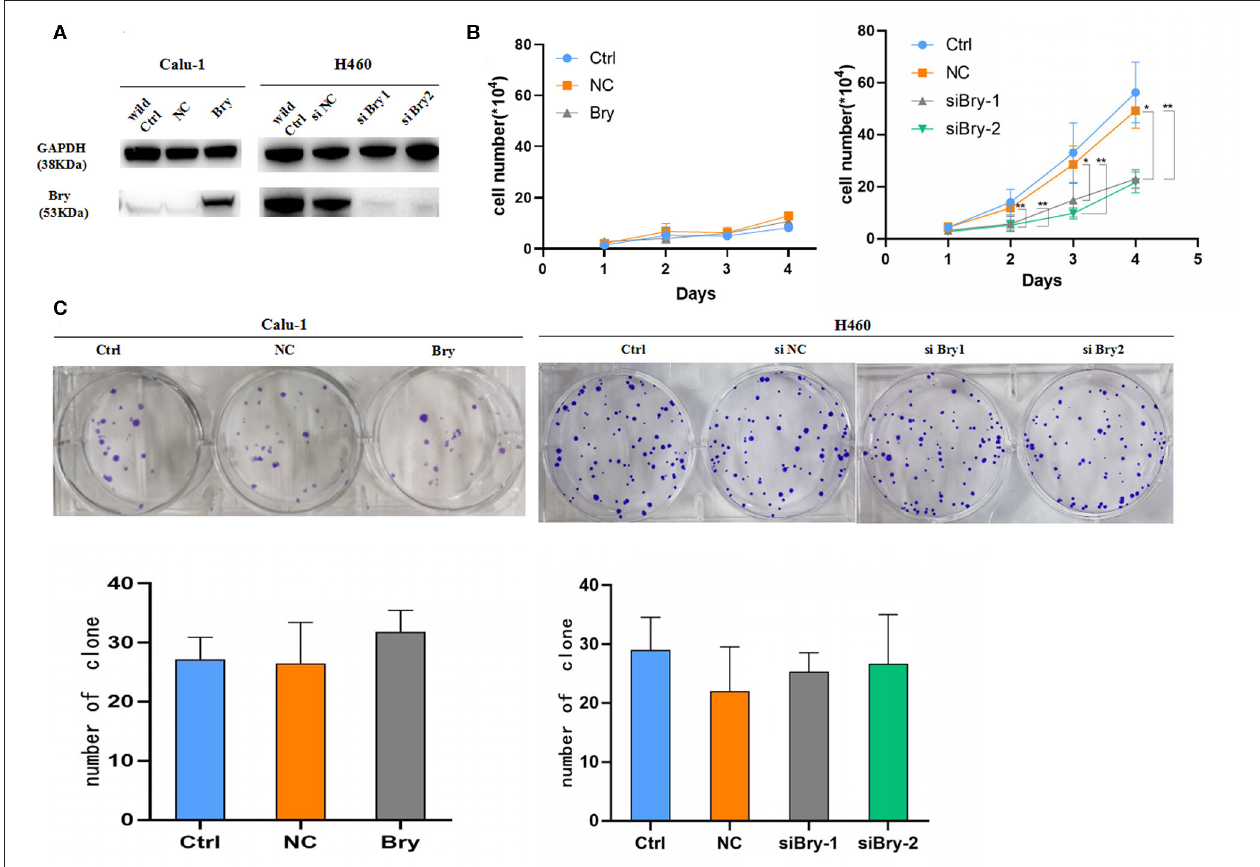
FIGURE 2 | Proliferation assays and colony formation assays to assess the effect of Bry in lung cancer cells. (A) The protein levels of Bry in Bry-overexpression Calu-1 cells or Bry-knockdown H460 cells compared with their respective control cells. (B) Cell proliferation assays to assess the proliferation capacity of Bry-overexpression Calu-1 cells and Bry-knockdown H460 cells. (C) Colony formation assays to assess the proliferation capacity of Bry-overexpression Calu-1 cells and Bry-knockdown H460 cells (* P < 0.05, ** P <